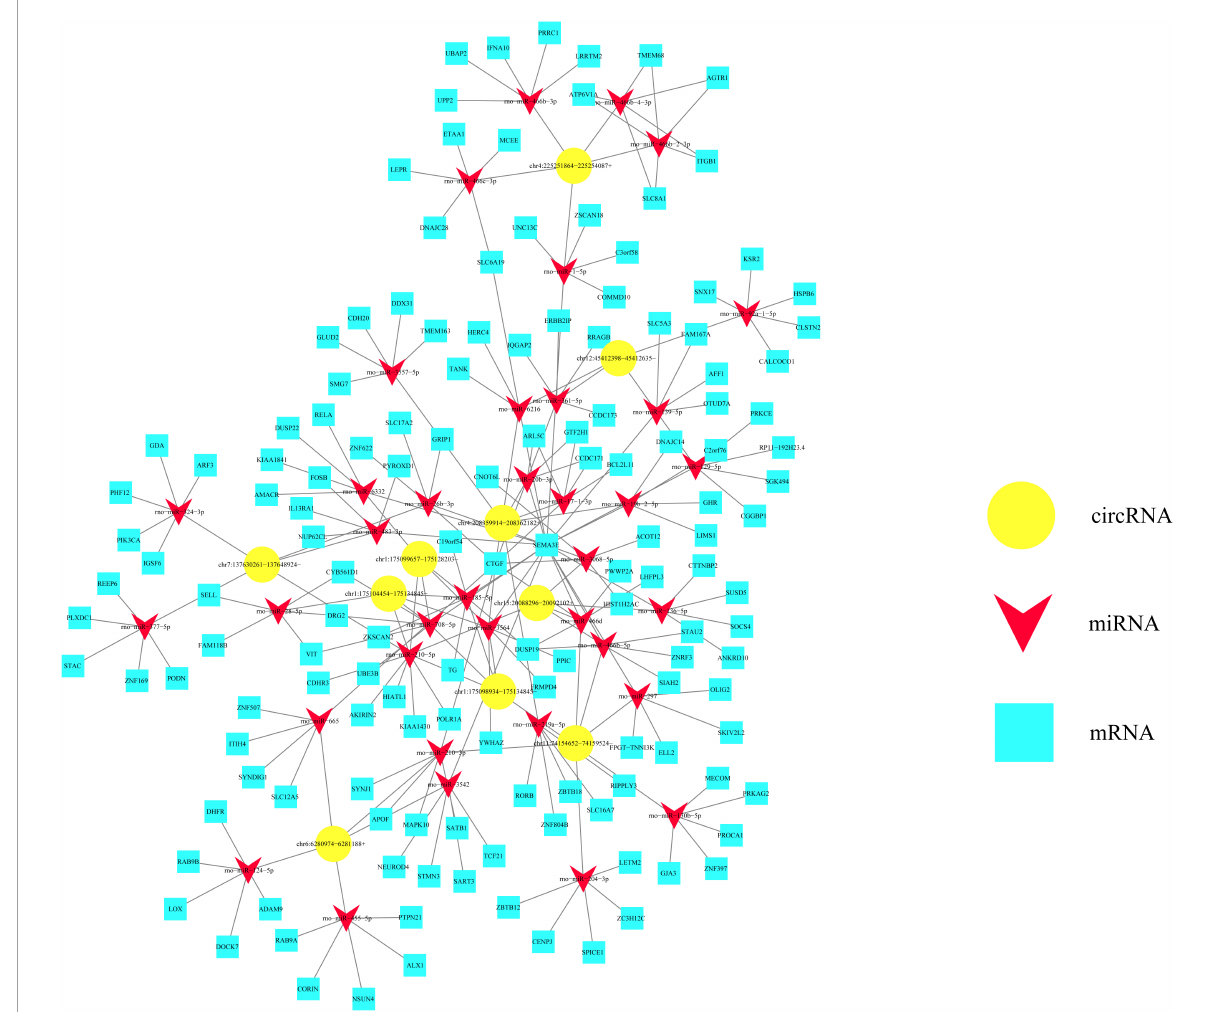
FIGURE6 Potential value of differentially expressed circular RNAs (circRNAs) from circulating exosomes is predicted based on the circRNA-miRNA-mRNA interaction network. This interaction network is centered by 10 kinds of differentially expressed circRNAs, as indicated by yellow polygons. These circRNAs could co-express and interact with 37 miRNAs which are indicated by red triangles, and 145 mRNAs which are indicated by blue